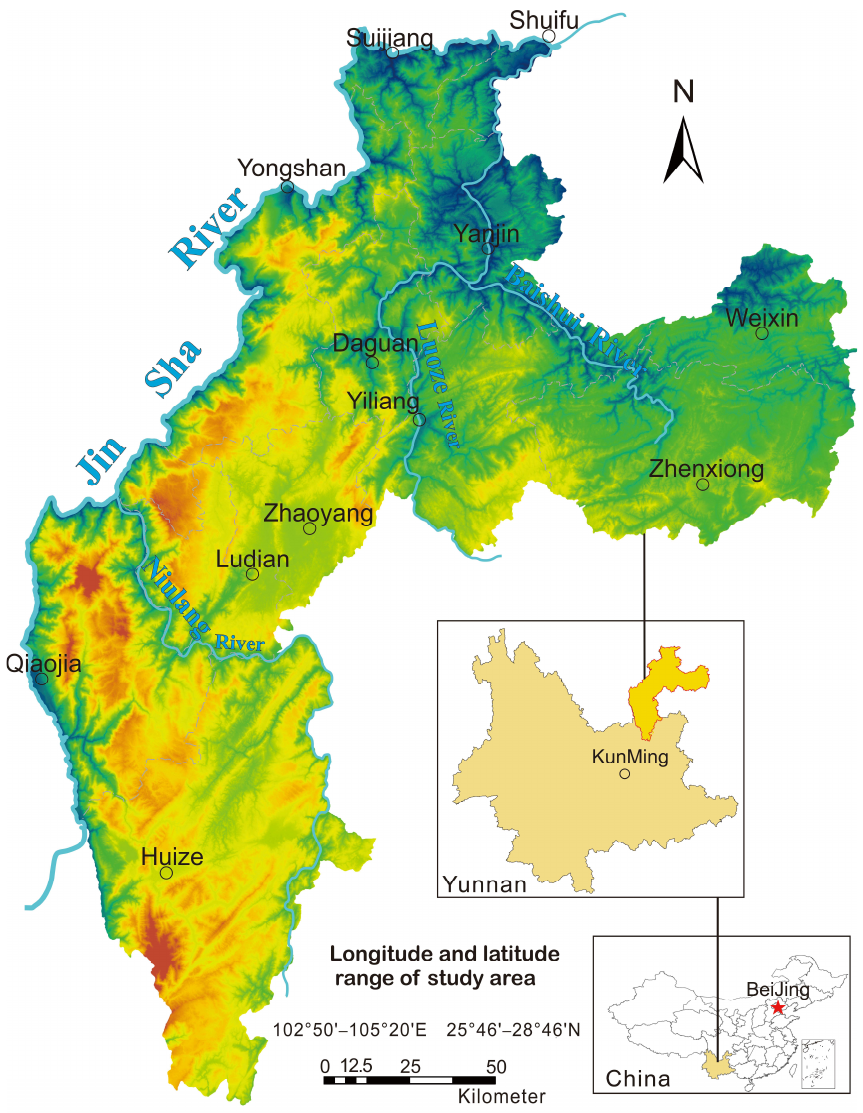
Figure 1. Location map of the study area.